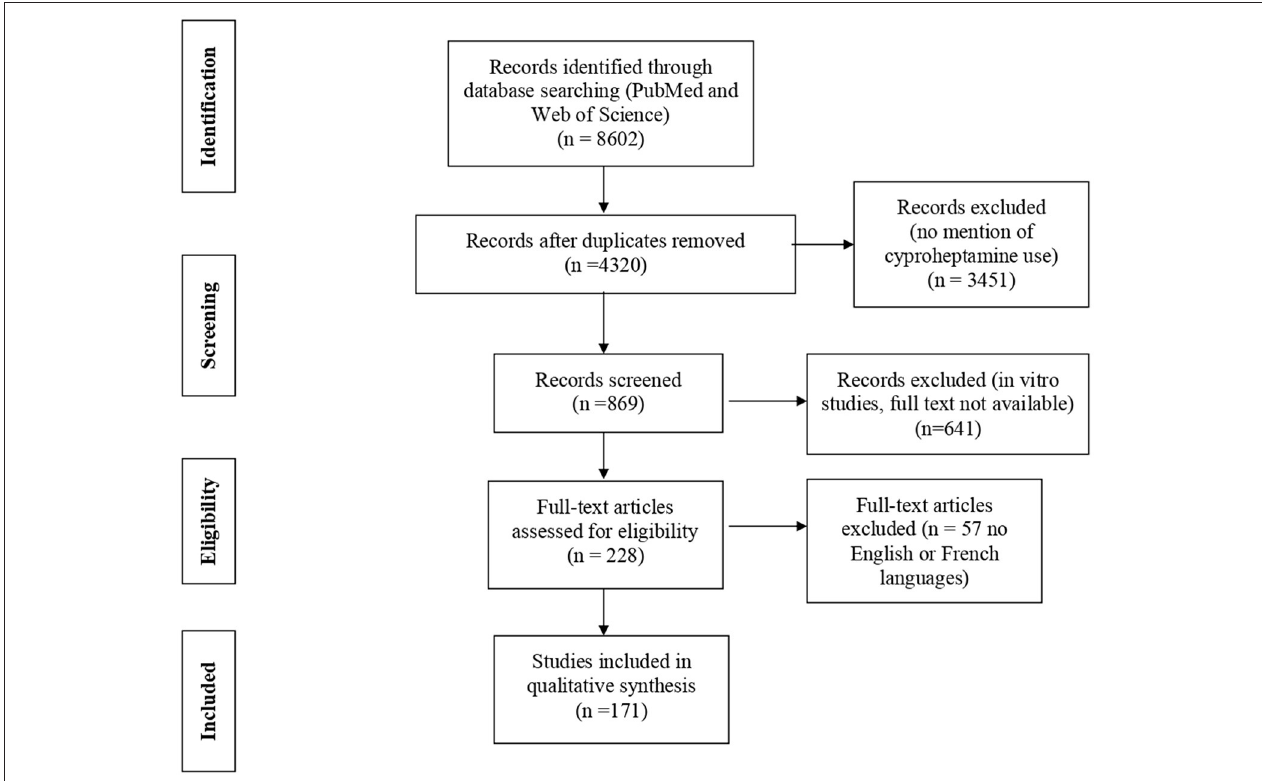
FIGURE 1 | Flow chart of the search strategy for the literature